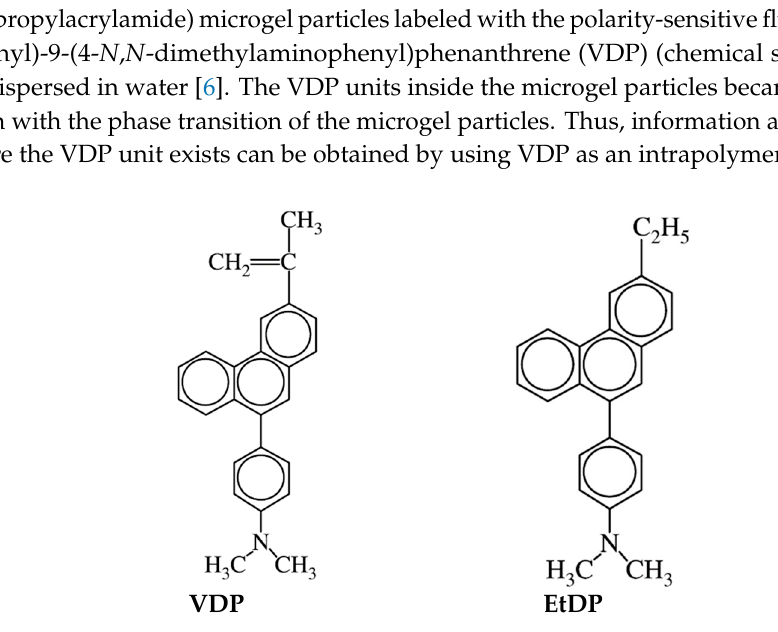
Figure 1. Chemical structures of 3-(2-propenyl)-9-(4- N , N -dimethylaminophenyl)phenanthrene (VDP) and 3-ethyl-9-(4- N , N -dimethylaminophenyl) phenanthrene (EtDP).